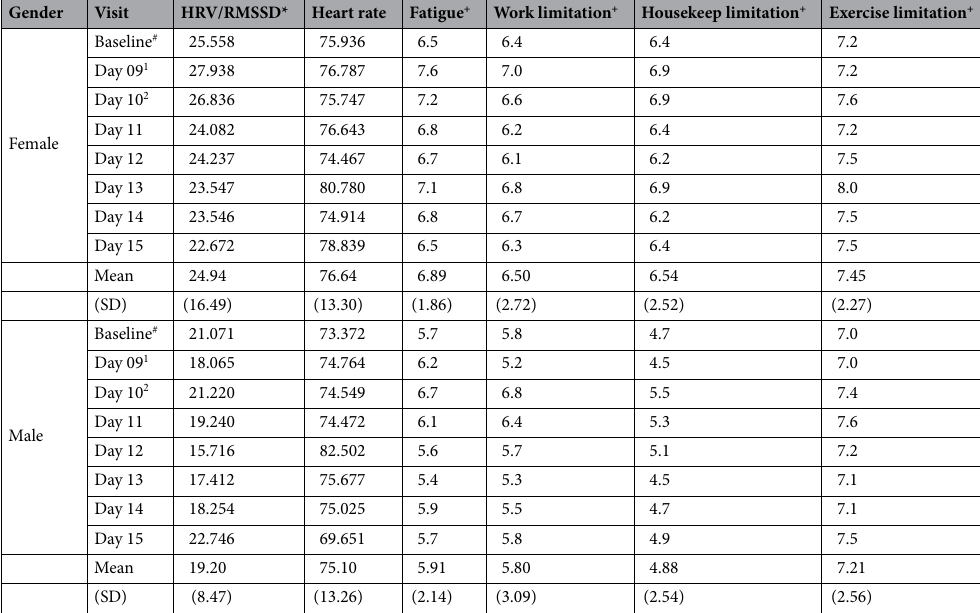
Table 2. Average heart parameter values and self-report ratings for female and male ME/CFS patients. *Heart rate variability/root mean square of the standard deviation. + Ratings (0–10). # Baseline is the average value from Day 1 to Day 8 (pre-walk test). 1 First six-minute walk test. 2 Second six-minute walk test; Standard deviations are in